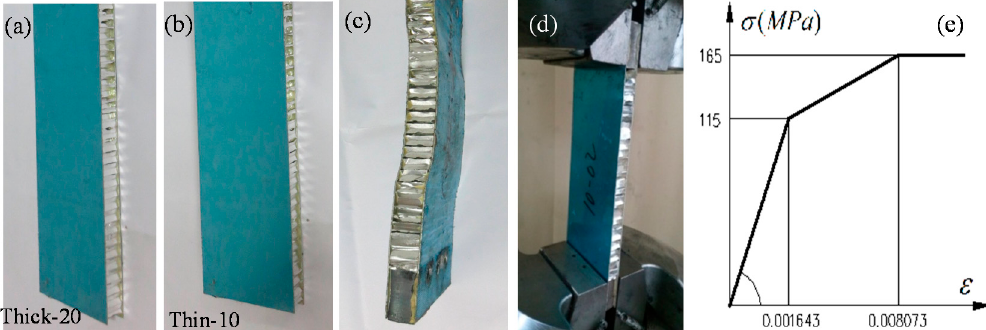
Figure 6. ( a ) The “thick” test piece; ( b ) the “thin” test piece; ( c ) the end reinforcement; ( d ) the test setup; and ( e ) the analytical material constitutive